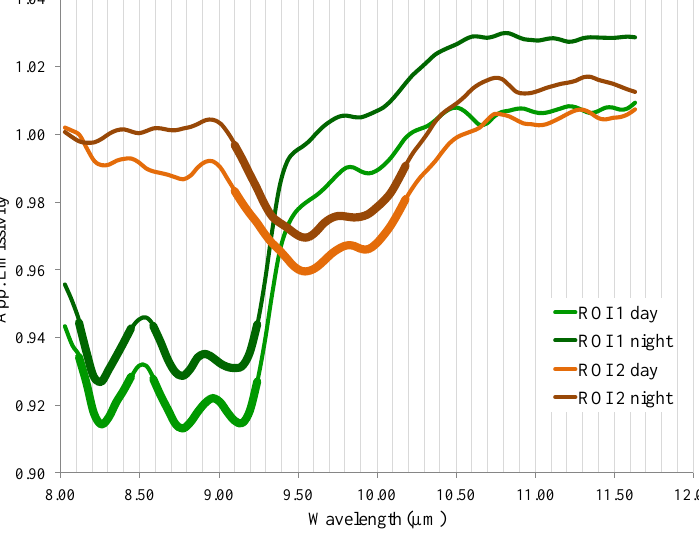
Figure 7. Day and night approximate (App.) emissivity spectra of the two ROIs, 1 and 2. Thick lines represent the mineralogical